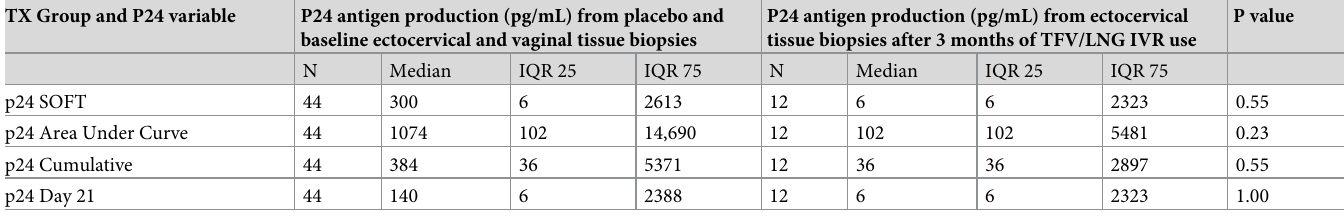
Table 6. p24 antigen production from ectocervical and vaginal tissue biopsies. TX Group and P24 variable